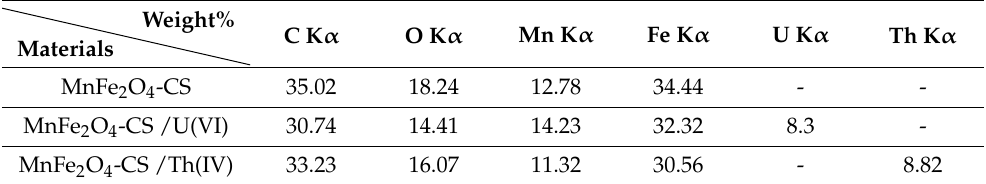
Table 2. EDS of CCsMFO nanocomposite and adsorbed metal ions percent.